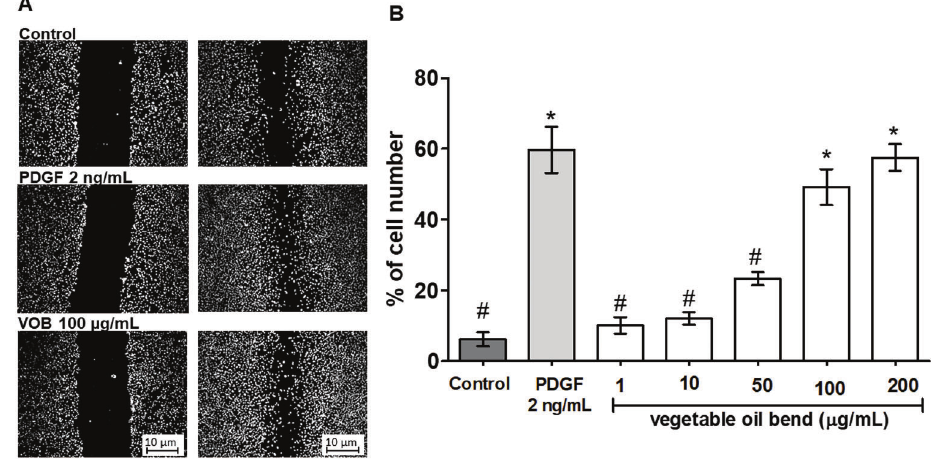
Figure 2. Vegetable oil blend (VOB) increased migration of fi broblasts in the scratch assay. Cells were treated with 1 to 200 m g/mL of VOB, 2 ng/mL of platelet derived growth factor (PDGF), or only with medium as control. A , Representative images were taken immediately after creating the wound (0 h) and after 16 h of incubation (100 (cid:1) magni fi cation; bar 10 m m). B , Percentage of cells after 16 h in the injured area compared to the scratch area at time zero (0 h). Data are reported as the mean ± SE of two independent experiments. *P o 0.05 compared to control group; # P o 0.05 compared to the positive control group (ANOVA and the Tukey ’ s post- hoc test).